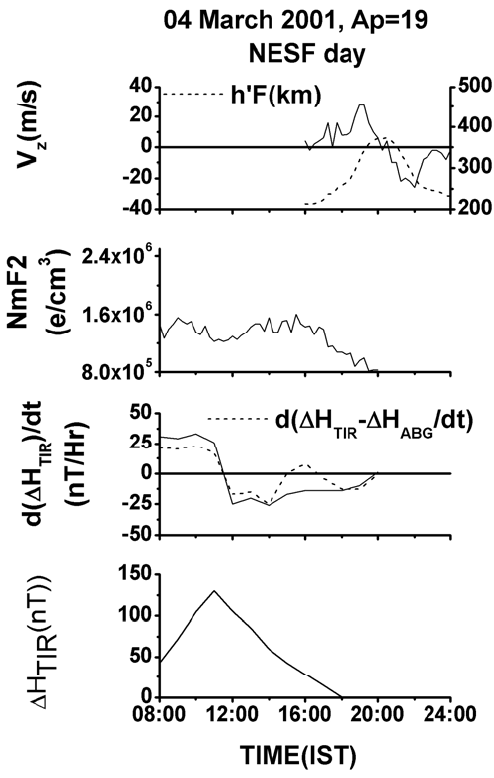
Fig. 1a. Variations in 1H TIR (bottom panel) along with the vari-